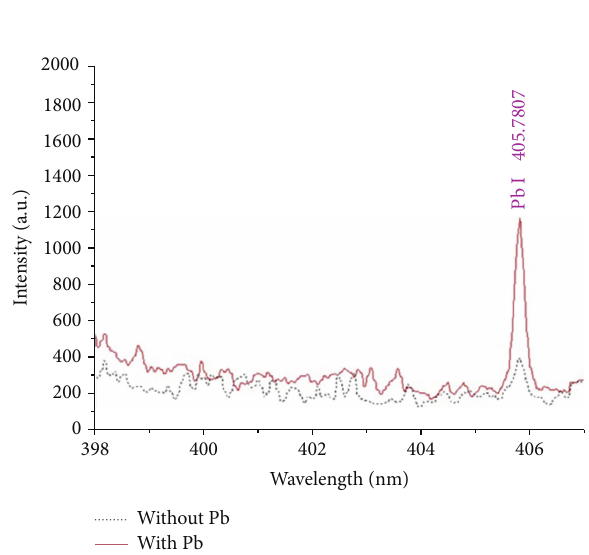
Figure 4: Typical lead spectrum at 405.78